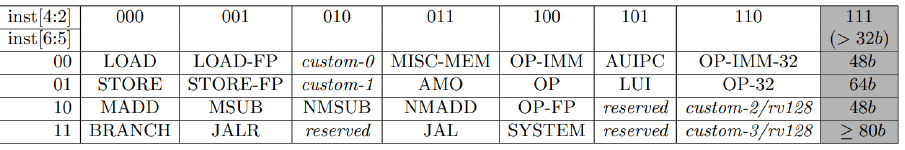
Figure 7. The custom instruction encoding space of RISC-V.